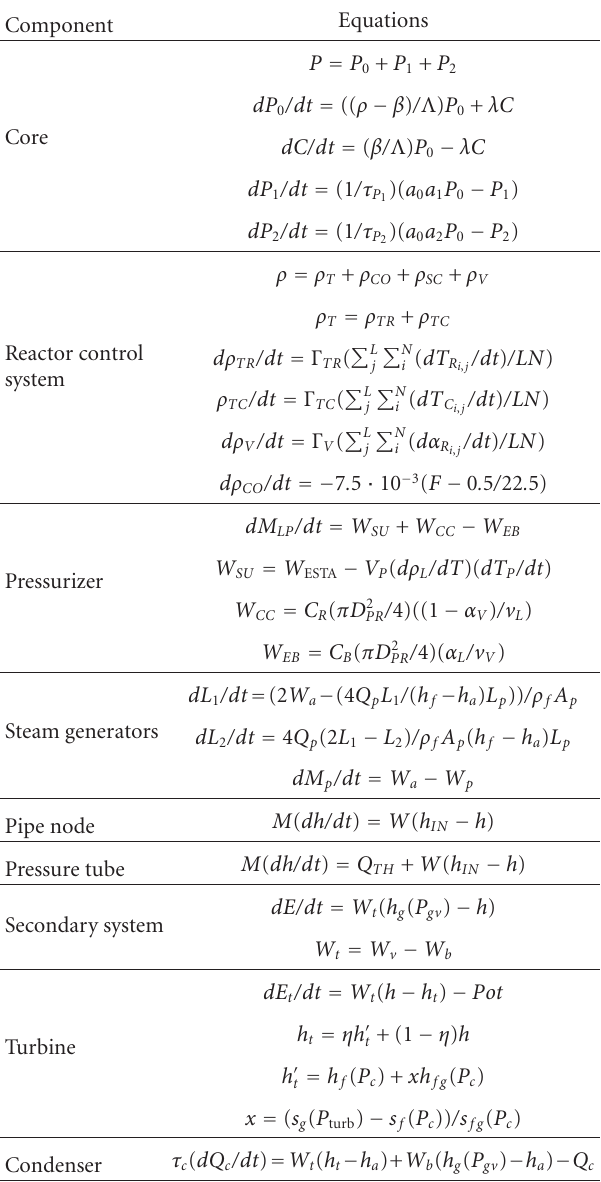
Table 2: Main equations of each component of the plant. Component